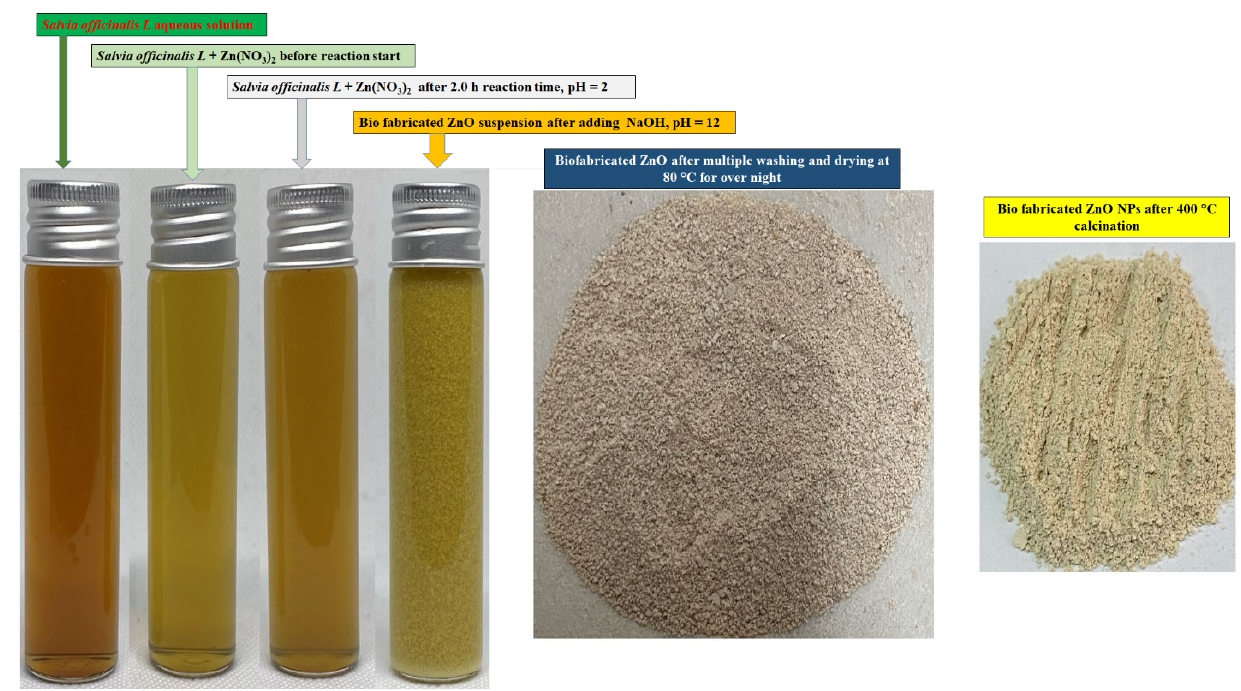
Figure 2. Synthesis process of ZnONPs using Salvia officinalis leaf extract.